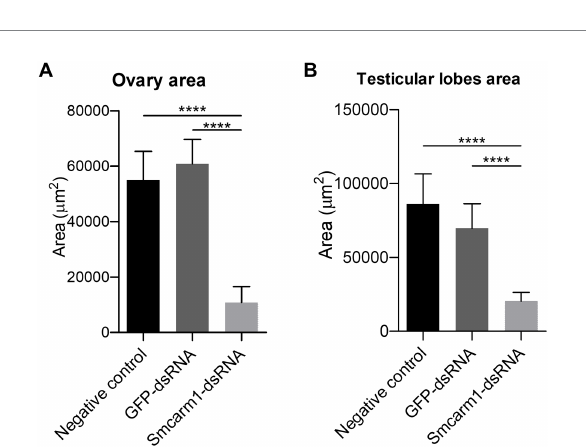
FIGURE 5 Morphometric analysis of ex vivo Sm carm 1 knocked down adult worms. Morphometric analysis of (A) ovary from female and (B) testicular lobes from male adult worms recovered from mice infected with schistosomula from negative control (black), unspecific GFP-dsRNA (dark gray), and Sm carm 1-dsRNA (light gray). Data were generated from three independent experiments and statistically analyzed using the Unpaired t -test. **** p < 0.0001.